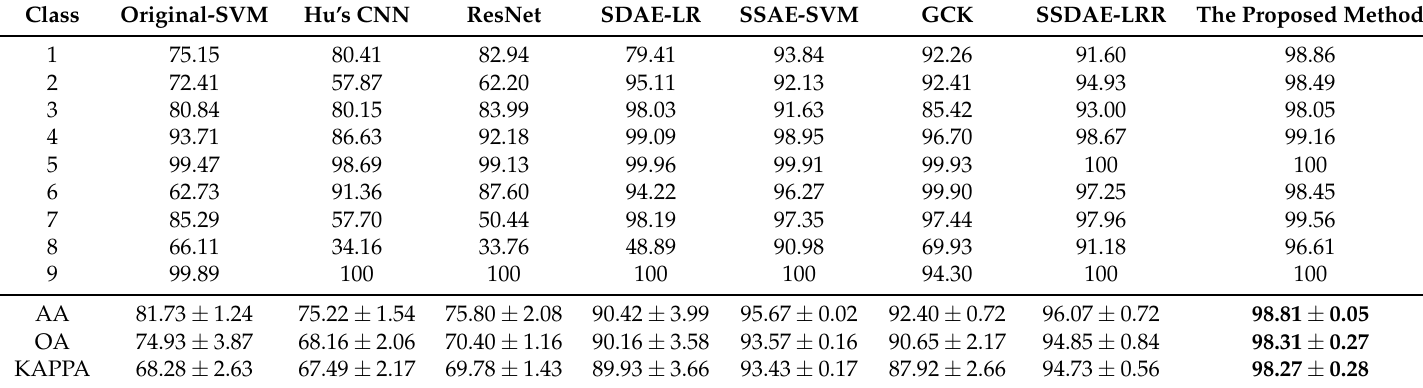
Table 5. Classification accuracy (%) of different methods on Pavia University dataset (a total of 100 labeled samples were used for training).